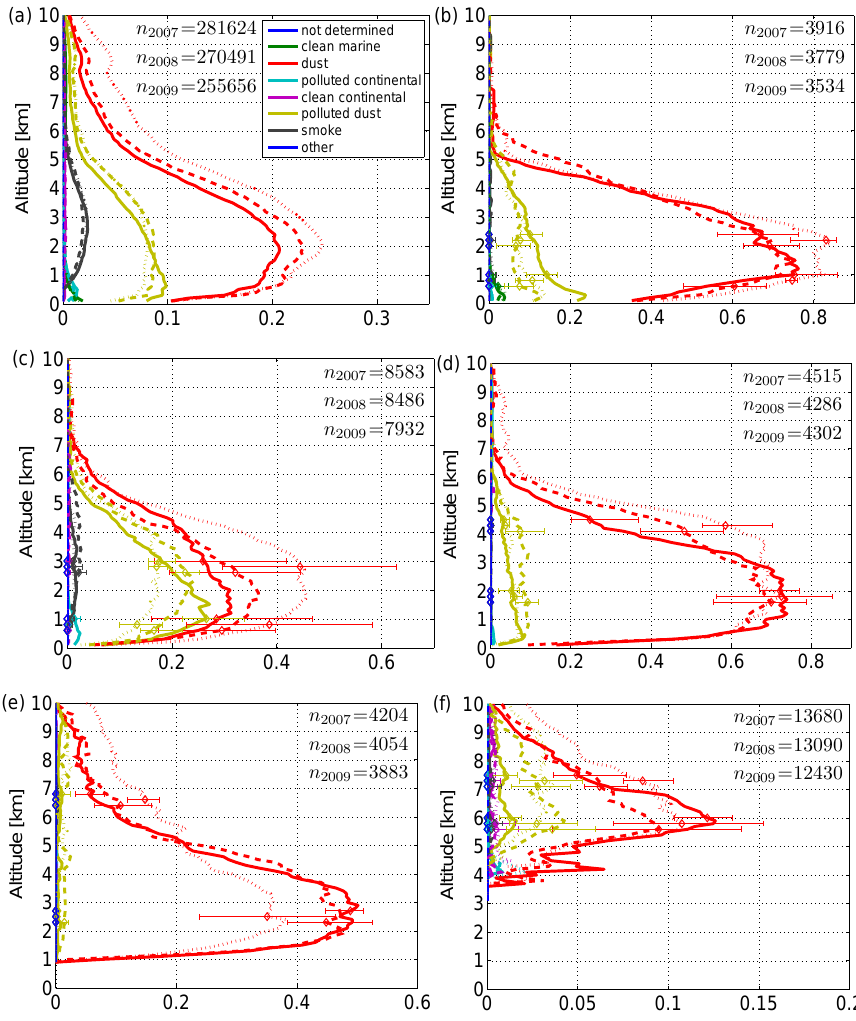
Fig. 2. Vertical distribution of the frequency of occurrence of the different aerosol types in (a) the entire region of interest, (b) the Arabian Sea, (c) the Ganges Plains, (d) the Indus Plains, (e) the Taklamakan Desert, and (f) the Tibetan Plateau. Note the different scalings of the respective x-axis. Data displayed separately for MAM 2007 (solid lines), 2008 (dotted lines), and 2009 (dashed lines). The numbers n x indicate the total number of sample profiles that was considered for each averaged profile. The error bars indicate the geographical variability within the